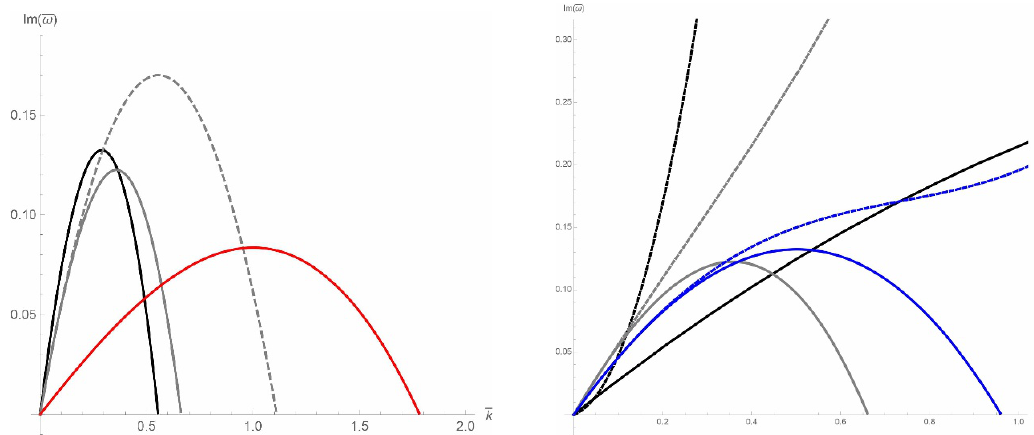
Figure 3 . The (cid:12)gure on the left exhibits the imaginary part of ! 3 at second order using (C.1) as a function of (cid:22) k for D = 7 for di(cid:11)erent values of the boost parameter: (cid:12) = 0 (black solid line), (cid:12) = 1 = 2 (grey solid line) and (cid:12) = 9 = 10 (red solid line). The grey dashed line represents the (cid:12)rst order result for (cid:12) = 1 = 2 obtained in (3.7). The (cid:12)gure on the right provides a comparison between blackfold and large D results for D = 5 and D = 7 for static strings and at the critical boost. The blue solid line is the blackfold result at second order for (cid:12) = 0 and D = 7 while the dashed line is the corresponding large D result at fourth order derived in [40]. The black solid line represents the imaginary part of ! 3 at (cid:12)rst order as in (3.7) while the black dashed line is the corresponding result at large D [24]. The grey solid line is the imaginary part of ! 3 as in (C.1) while the grey dashed line is the corresponding large D result